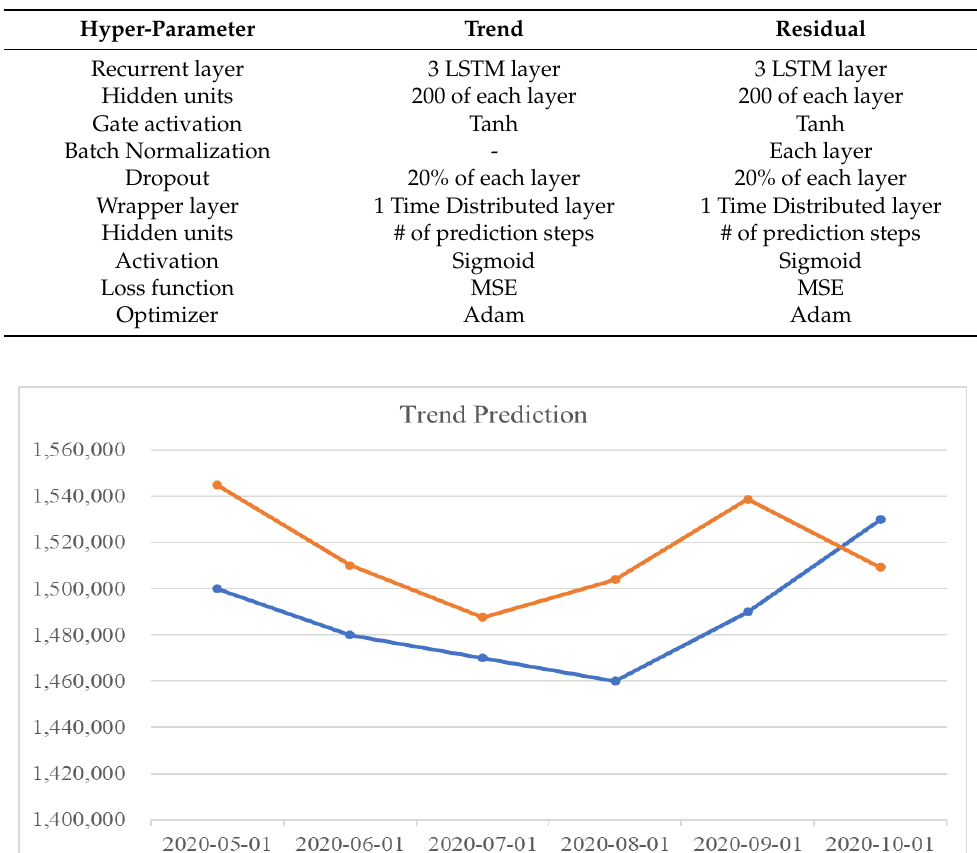
Table 4. Model configuration.